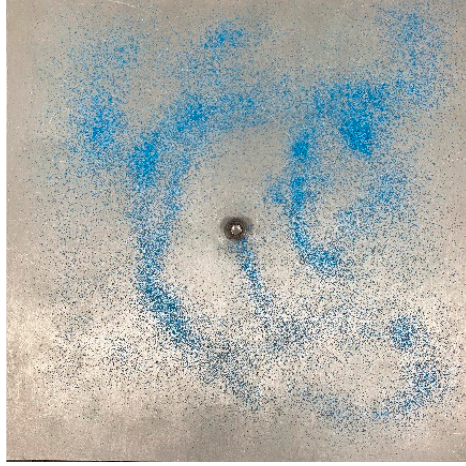
Figure 3. Fine colored sand spread on the plate.